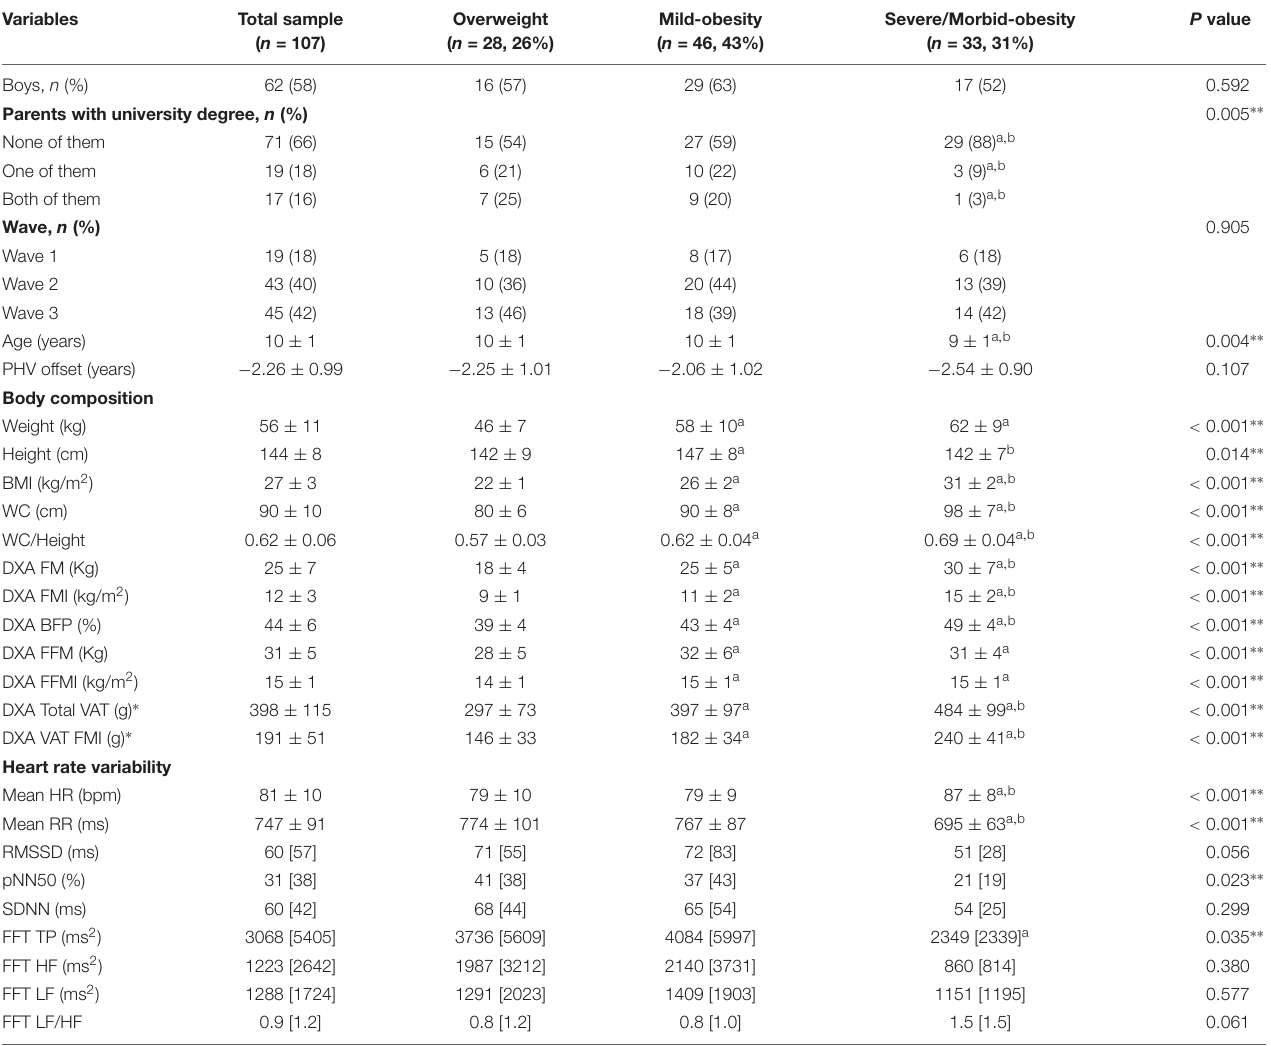
TABLE 1 | Descriptive characteristics of